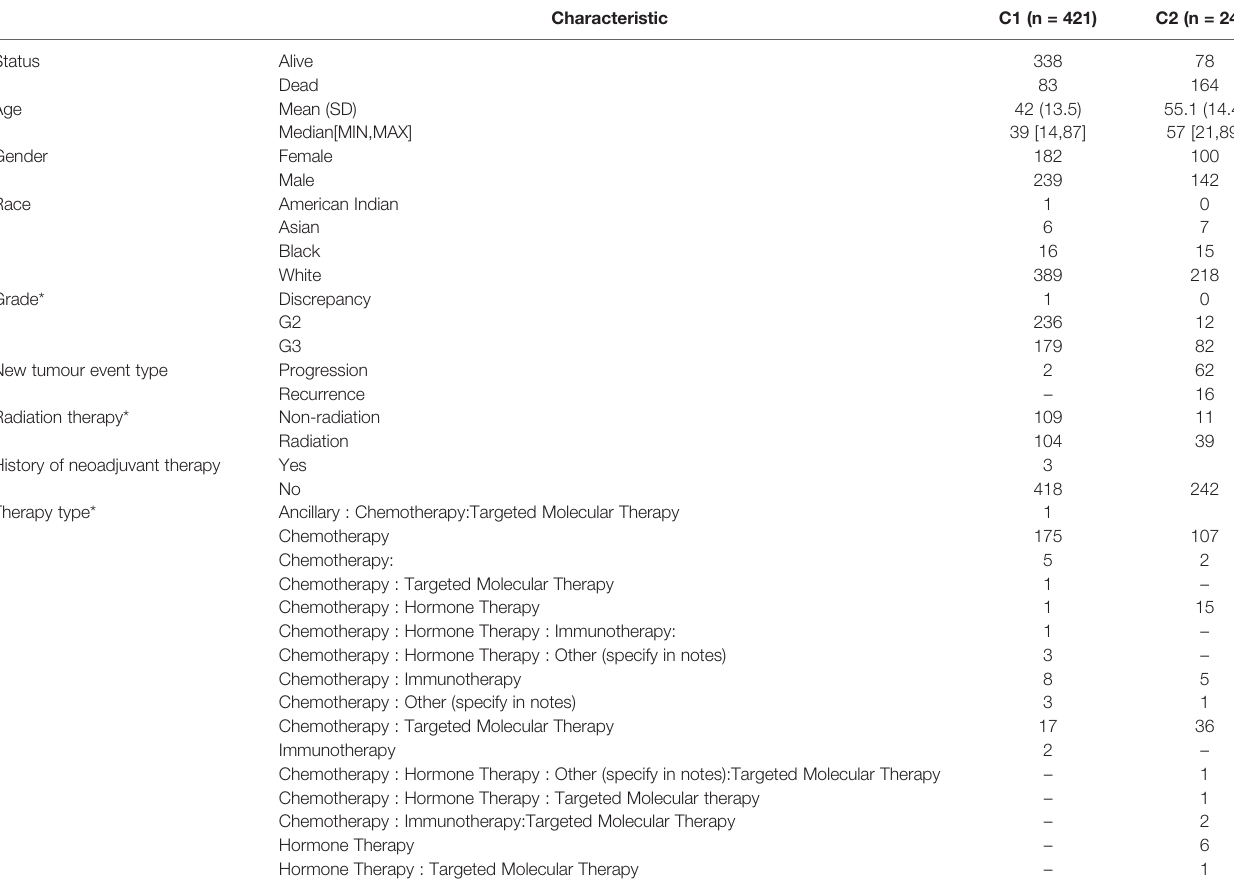
TABLE 1 | Distribution of clinical data of the samples in the two subgroups.